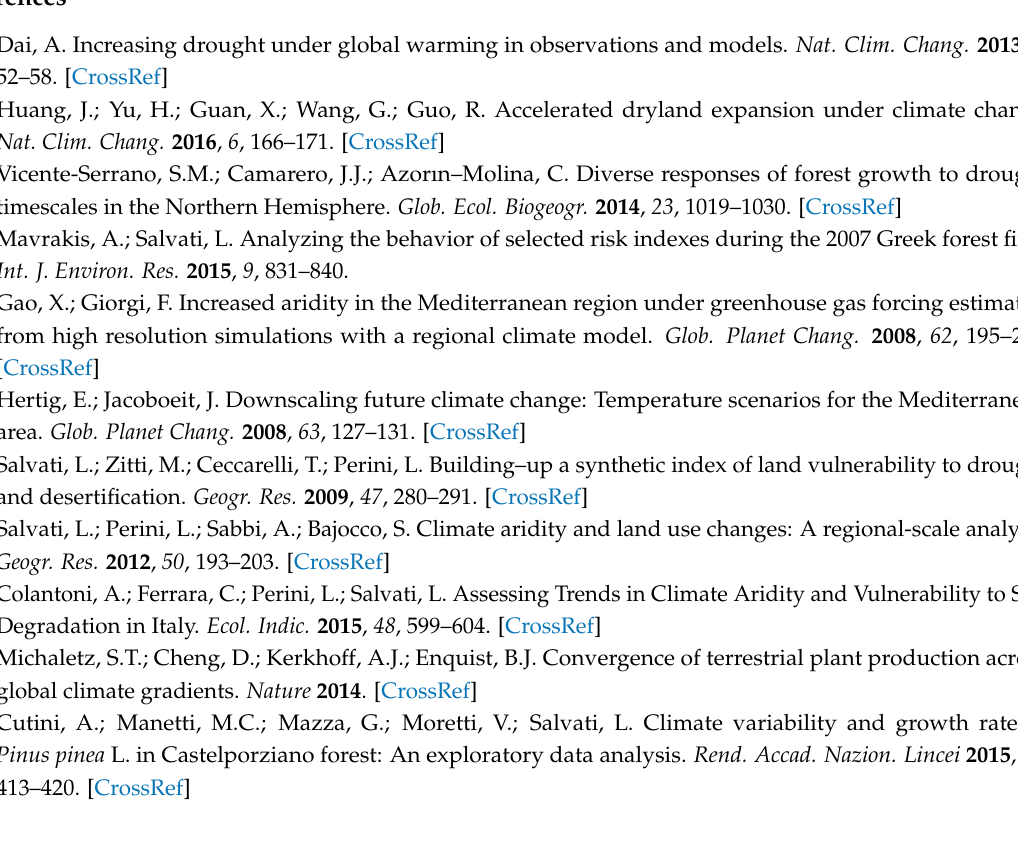
Figure S1: title, Table S1: title, Video S1: